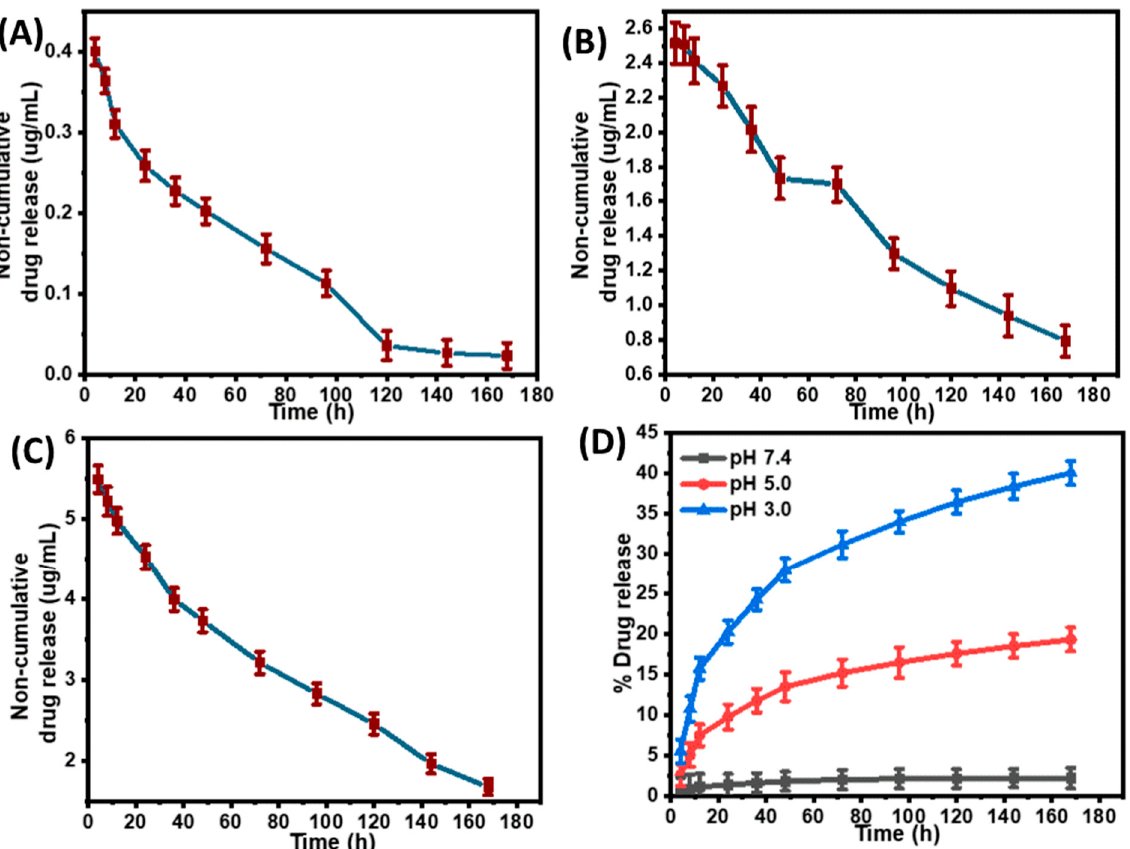
Figure 2. ( A ), ( B ) and ( C ) are representing non-cumulative gentamicin release at pH 7.4, 5 and 3, respectively; and ( D ) is representing cumulative percent release of gentamicin at all pH conditions from G-PDA 0.6:1. Data were mean ± SD ( n = 3).